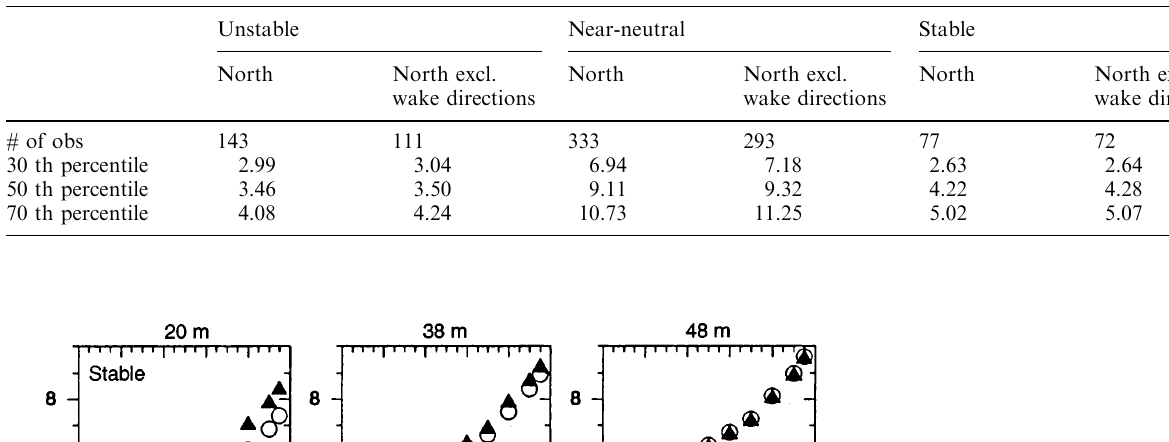
25 (cid:176) , and 315 (cid:176) –325 (cid:176) ). Note: The data contained in this table di(cid:128)er from those in Table 1 because here the wind direction is defined